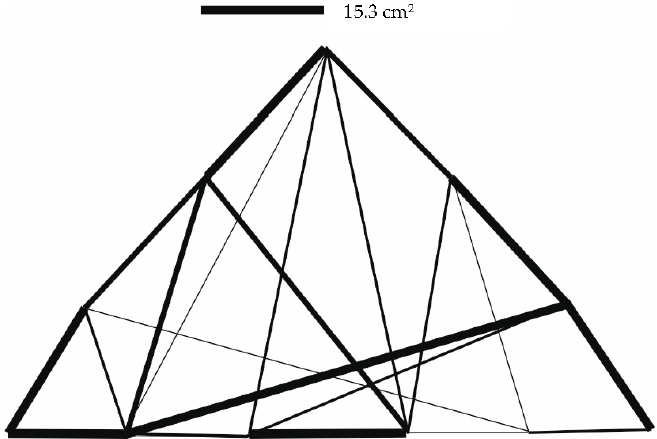
Figure 8. Truss structure after optimization—8 individuals in population (case b).